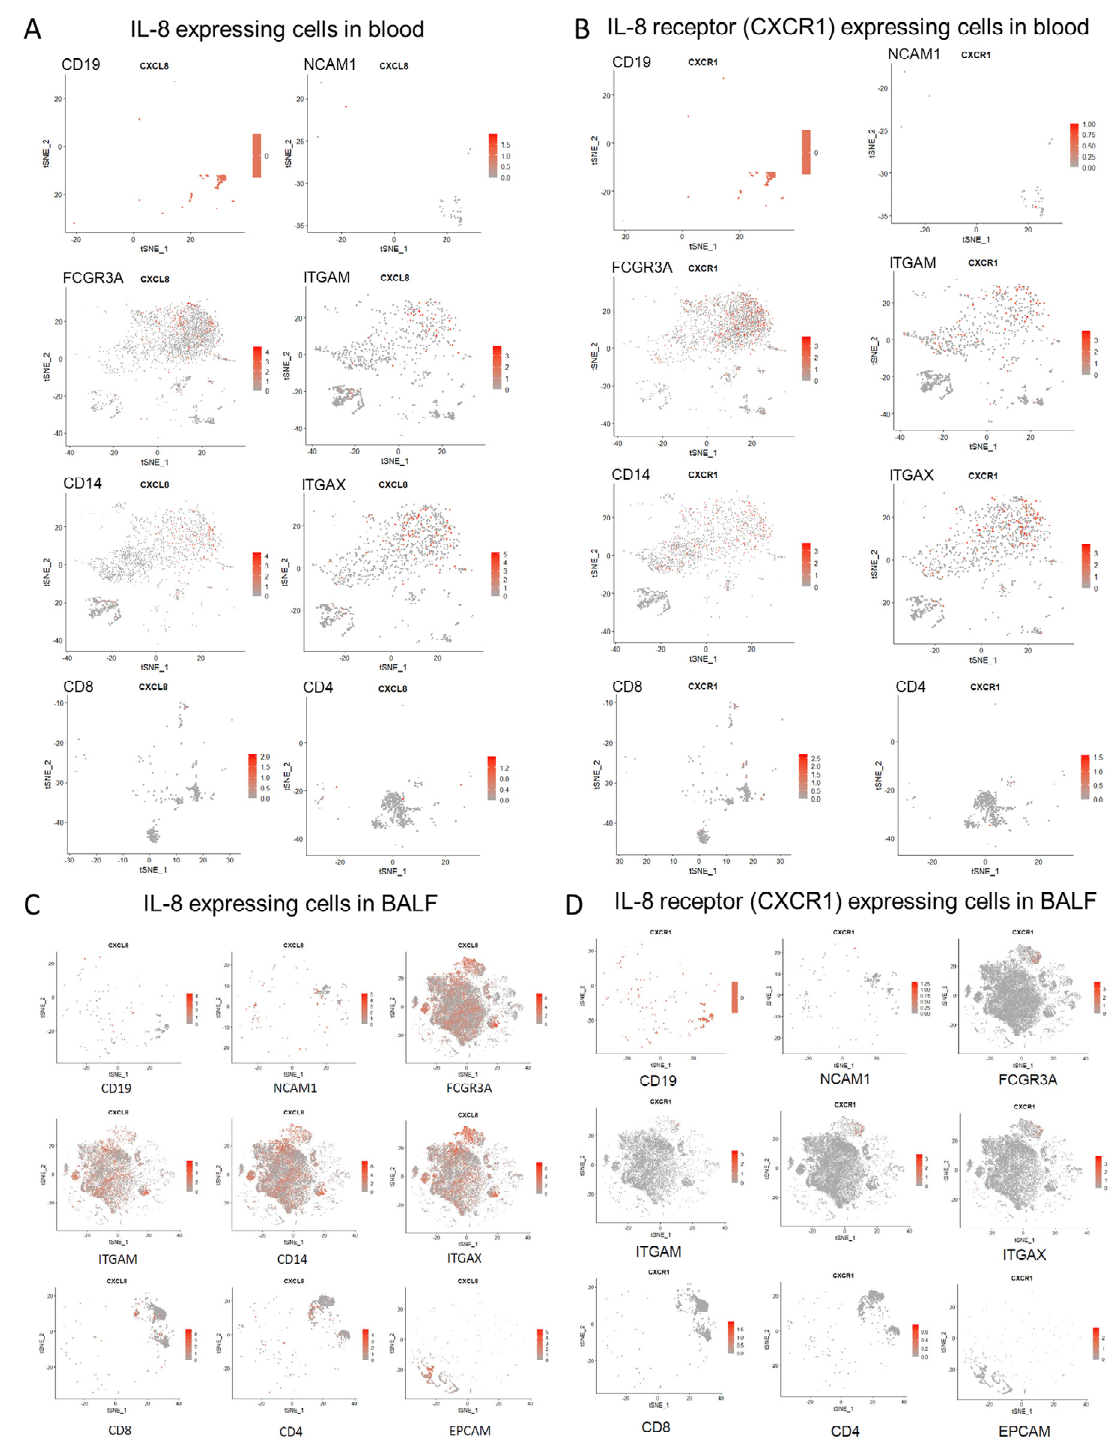
Figure 5. Re-analyses of single-cell RNA sequencing data to show individual immune cells expressing IL-8 and its receptor in severe COVID-19 patients. ( A ) Abundance of IL-8 transcript (CXCL8)